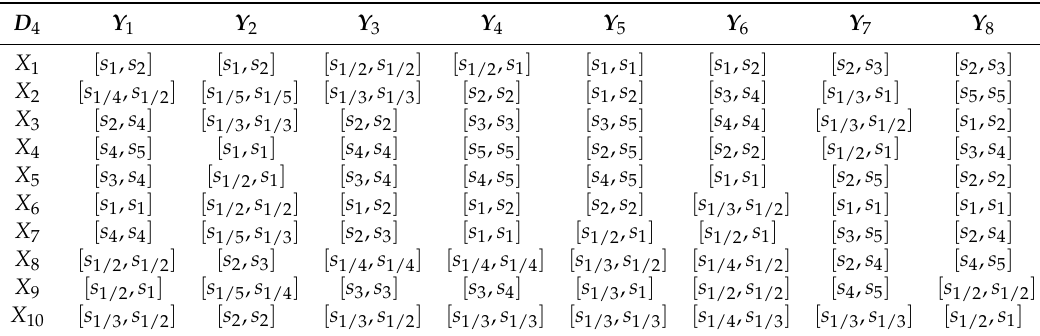
Table A4. Linguistic evaluation information matrix of D 4 .